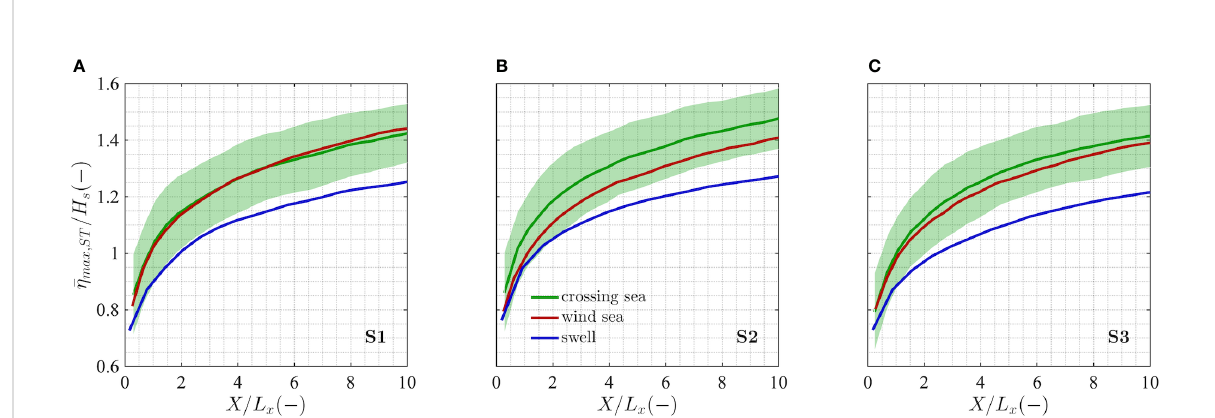
FIGURE 8 Empirical space-time expected normalized maximum wave crest height ( (cid:1) h max,ST /H s ) for the wind sea (red), swell (blue) and crossing sea (green) conditions of cases S1 (A) , S2 (B) and S3 (C) as a function of the normalized sea surface area width ( X/L x ). The standard deviation of the crossing seas (shaded area) is also